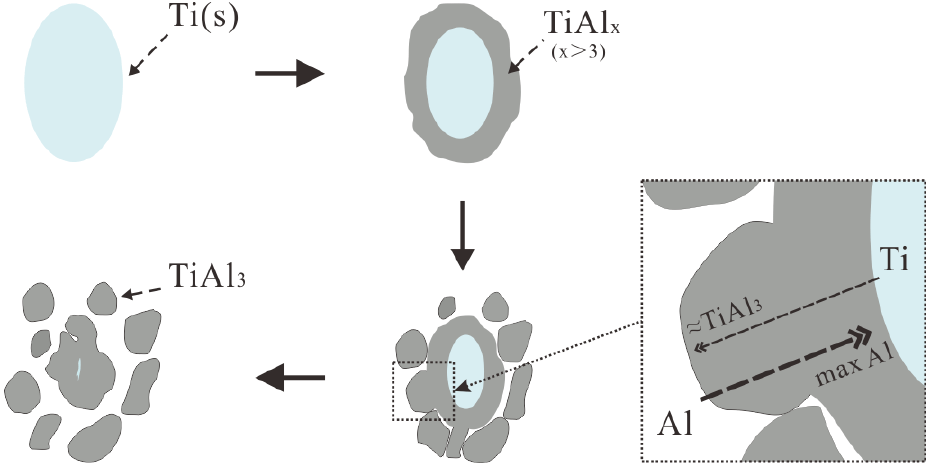
Figure 9. The Ti – TiAl x mechanism in Ti-sponge route to prepare Al – Ti – B Master Alloy. Figure 9. The Ti–TiAl x mechanism in Ti-sponge route to prepare Al–Ti–B Master